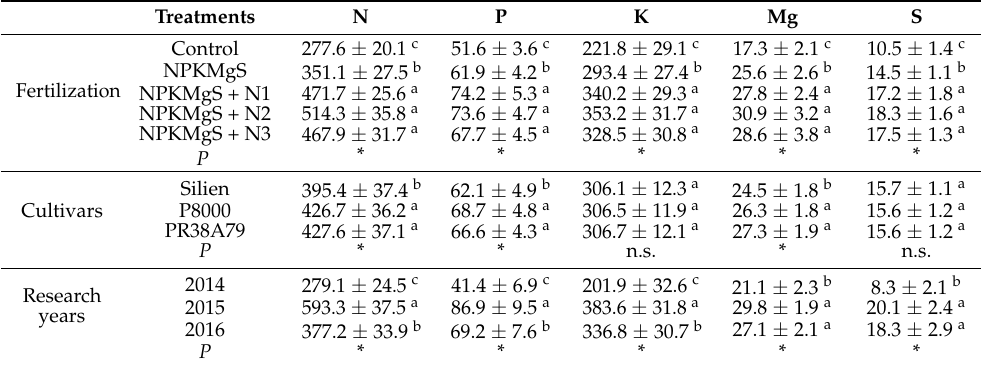
Table 6. Nitrogen, phosphorus, potassium, magnesium and sulphur uptake with the yield of maize grown for silage (kg · ha − 1